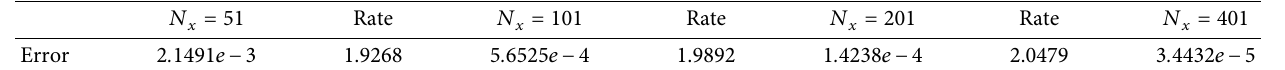
Table 4: l -norm error and temporal convergence rate of numerical 2